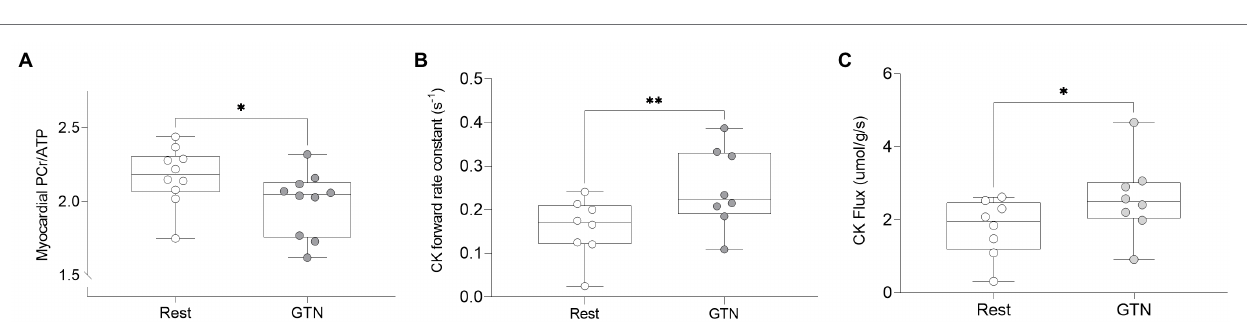
FIGURE 3 | The effects of GTN infusion on Myocardial energetics as assessed by 31 P magnetic resonance spectroscopy showing (A) myocardial Phosphocreatine/ ATP (PCr/ATP) ratio, (B) creatine kinase pseudo-first-order forward rate constant, and (C) creatine kinase flux. * p < 0.05 and ** p < 0.01.